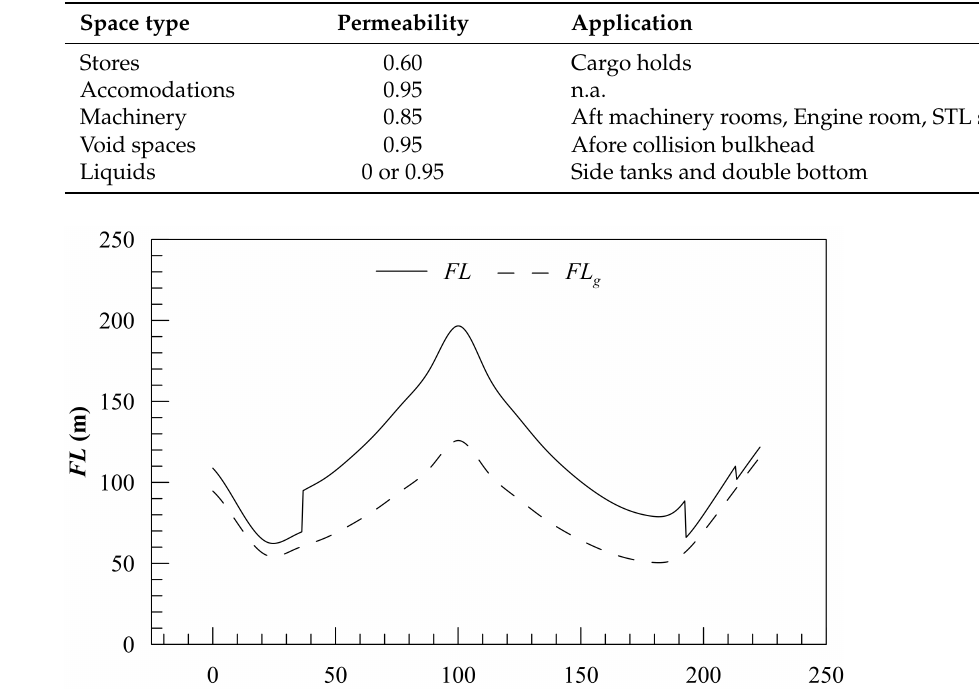
Figure 4. Geometric and corrected floodable length for the test ship.